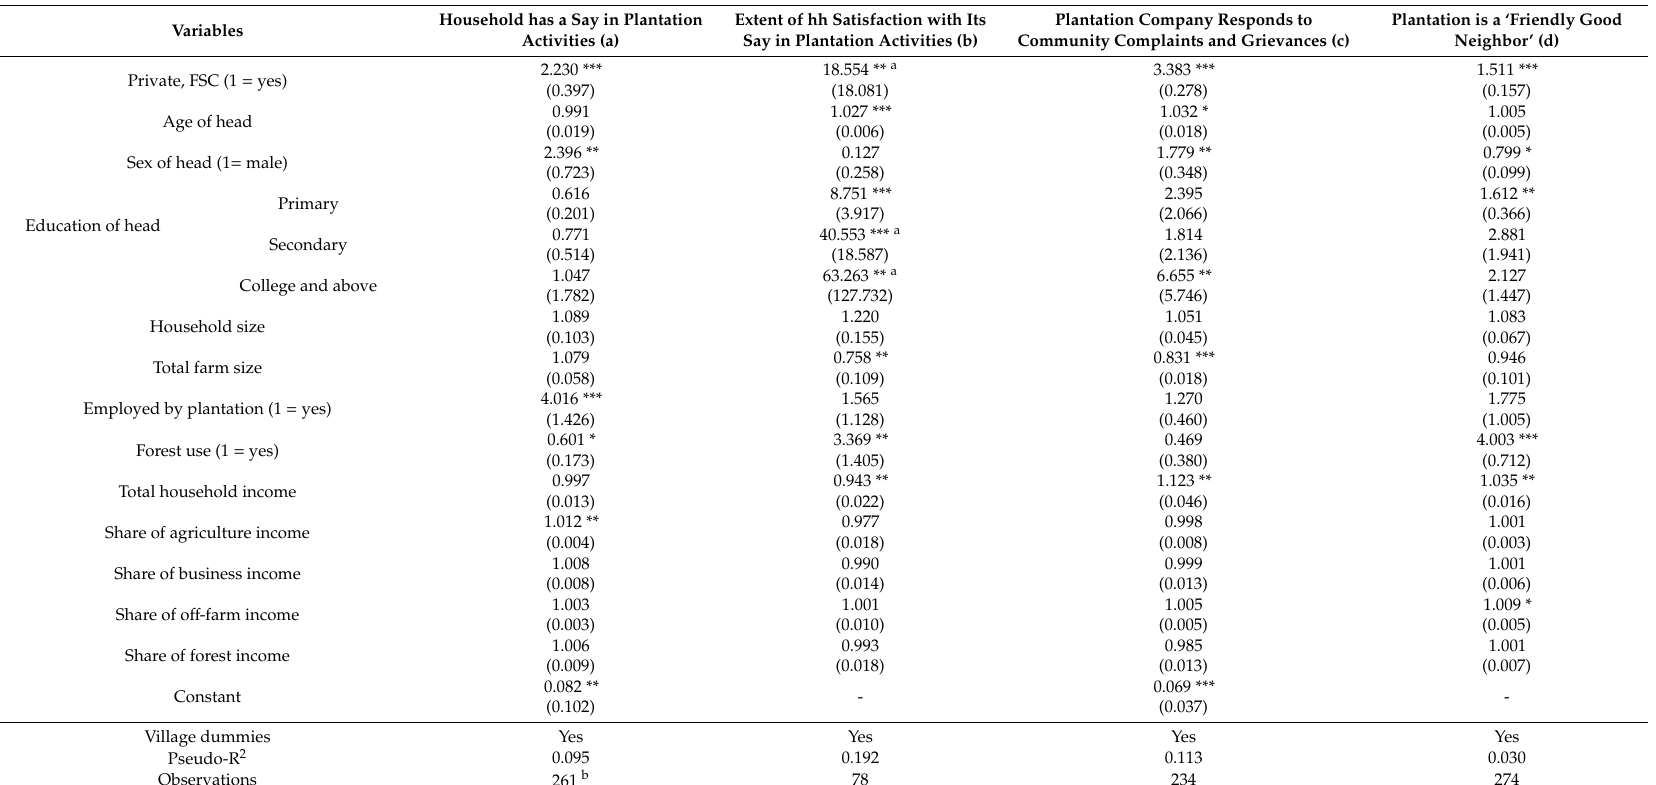
Table 3. Odds Ratios of Estimated Logit